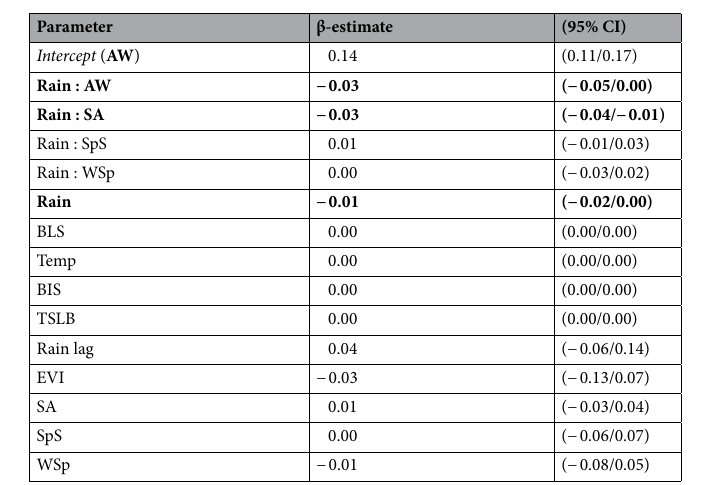
Table 2. The observed relationship between the response variable (EMD) and the model-averaged parameters from each top model (β-estimate ± 95% CI) for consecutive seasons within the same year. AW indicates autumn–winter comparison, SA summer-autumn, SpS spring–summer and WSp winter-spring, Temp temperature, BIS percentage of UD burned within season, BLS percentage of UD burned in last fire before season, TSLB time since last burn in UD before season. Intercept taken as AW. The β-estimates with CI that do not overlap zero are indicated in